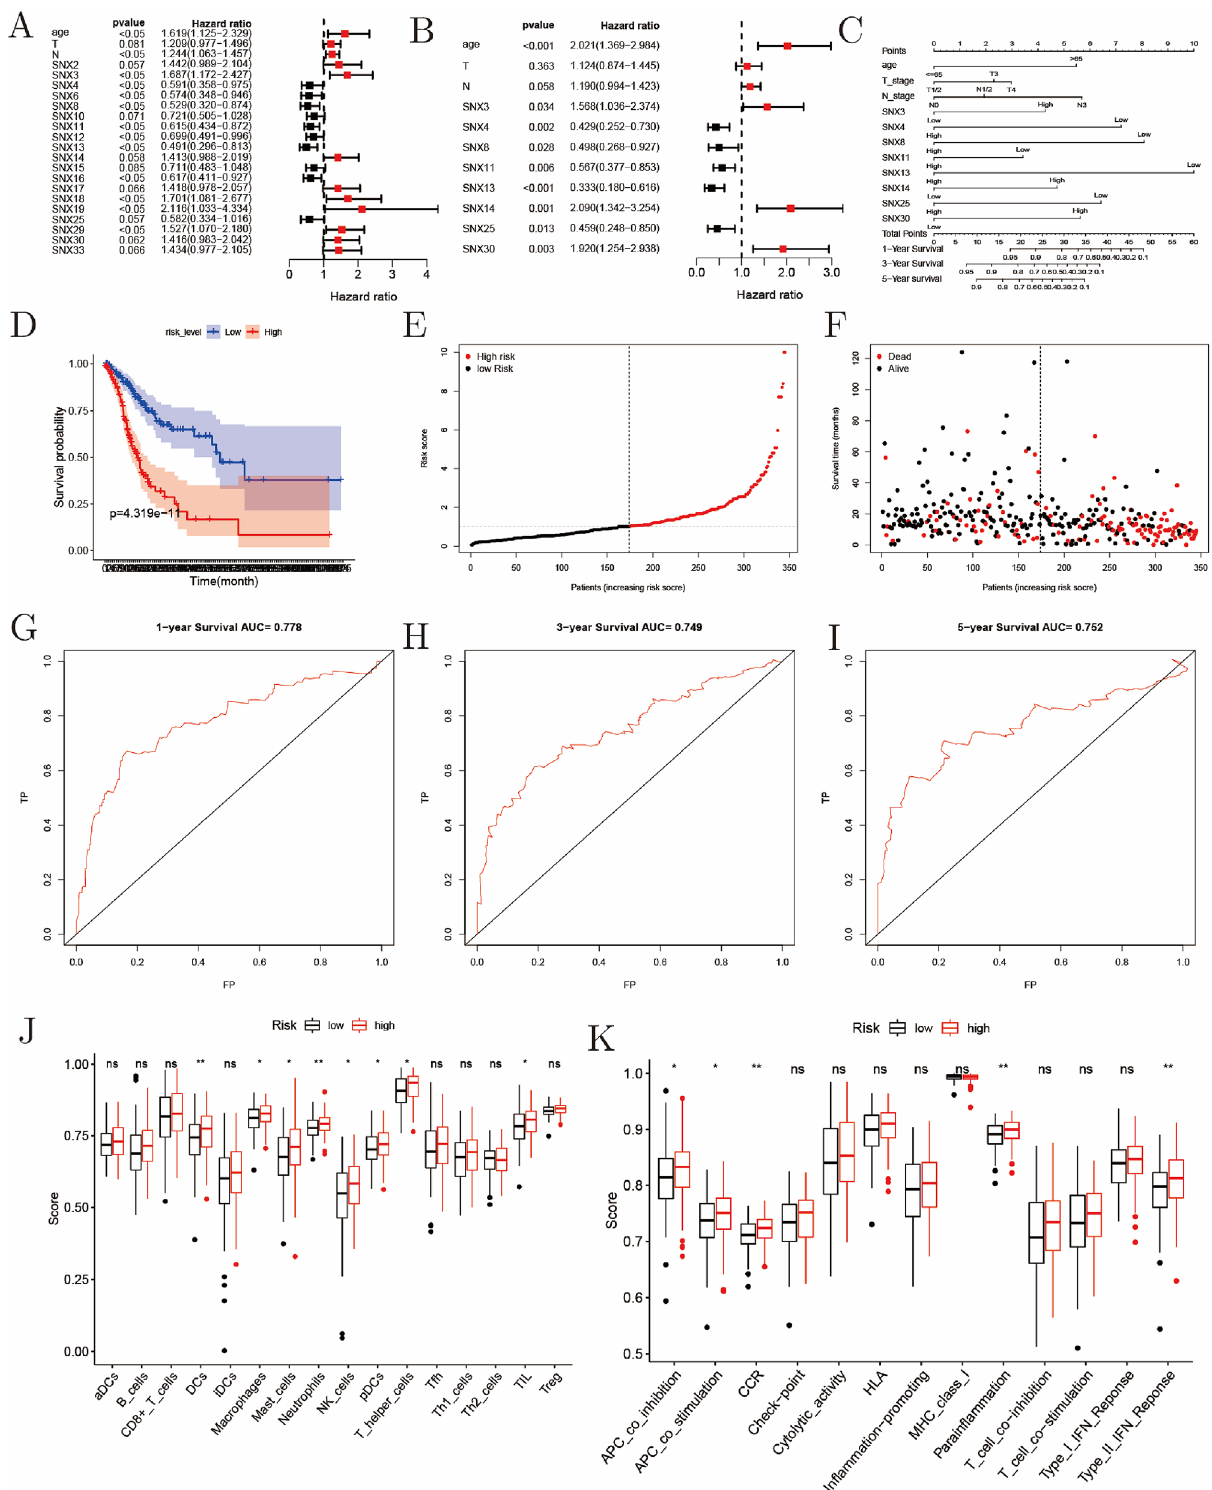
Figure 7. Risk classification model constructed based on multivariate analysis using data in TCGA. ( A–B ) Univariate and multivariate analysis of role of SNXs transcriptional abundance in OS, visualized with forest plots. ( C ) A nomogram to estimate one-, three- and five-year OS. ( D ) KM curve of those with high or low risk judged by the model. ( E – F ) Risk distribution plots of all the 345 patients with GC. ( G–I ) Receiver operating curves aiming at one-, three- and five-year OS prediction. ( J–K ) Evidence of co-existence of higher risk and deeper tumor immune